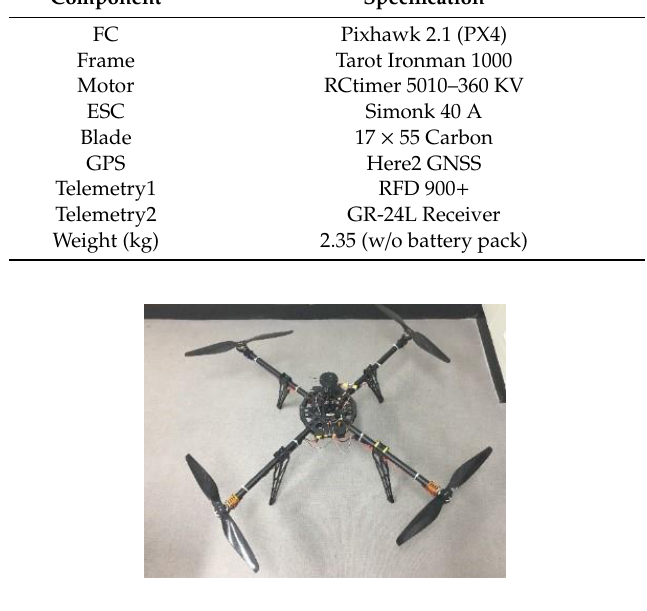
Table 5. Specifications of the GCS. Component